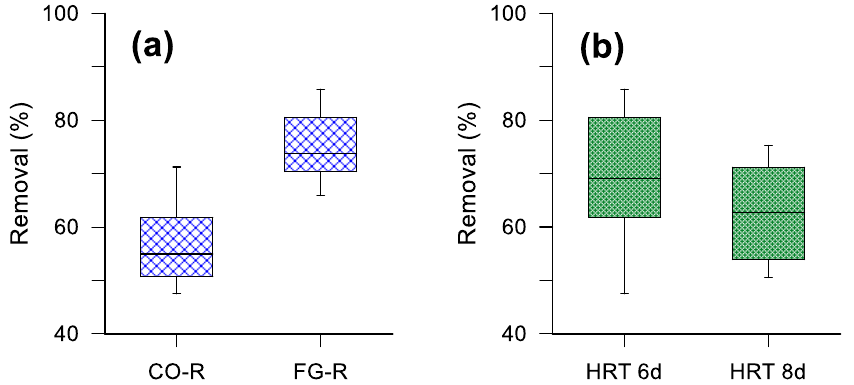
Figure 4. Box – whisker plots of pyraclostrobin removal efficiencies for the entire experimental period: ( a ) overall for each CW unit; ( b ) for HRTs of 6 and 8 days.